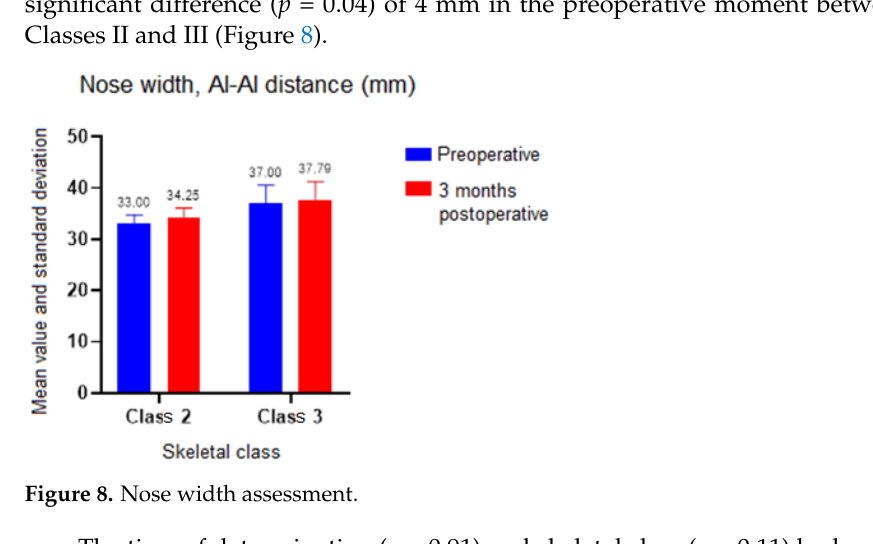
Figure 9. Nose width assessment, insertions of the nasal fins.